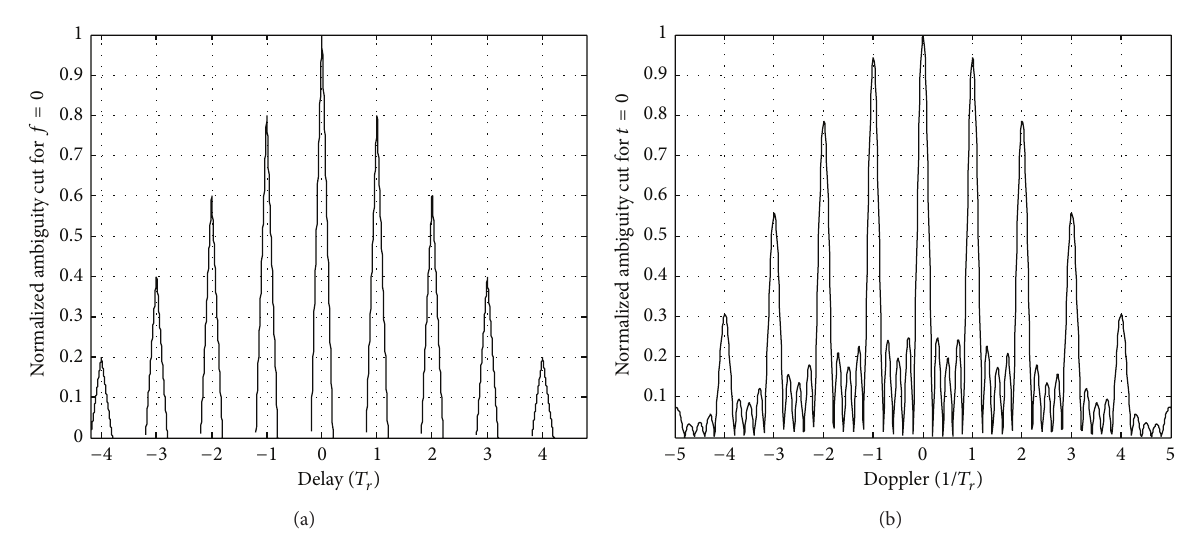
Figure 4: The range and velocity ambiguity function of coherent pulse train.